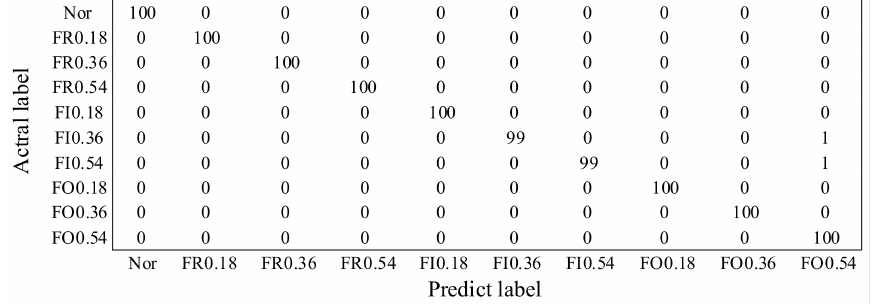
Figure 5. Confusion matrix of the fault diagnosis results for DA task B → D.